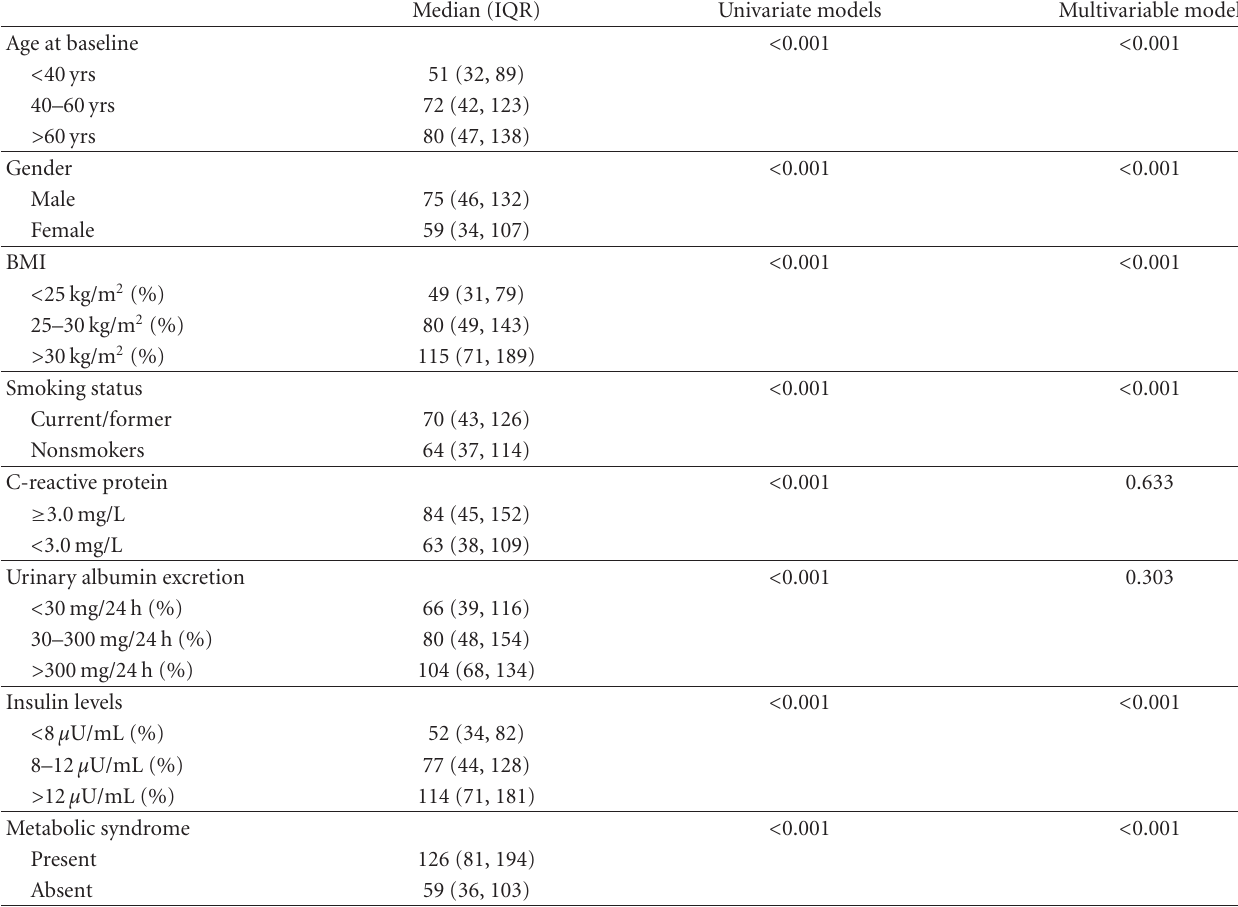
Table 2: PAI-1 antigen levels (ng/mL) for the association of the metabolic syndrome and other